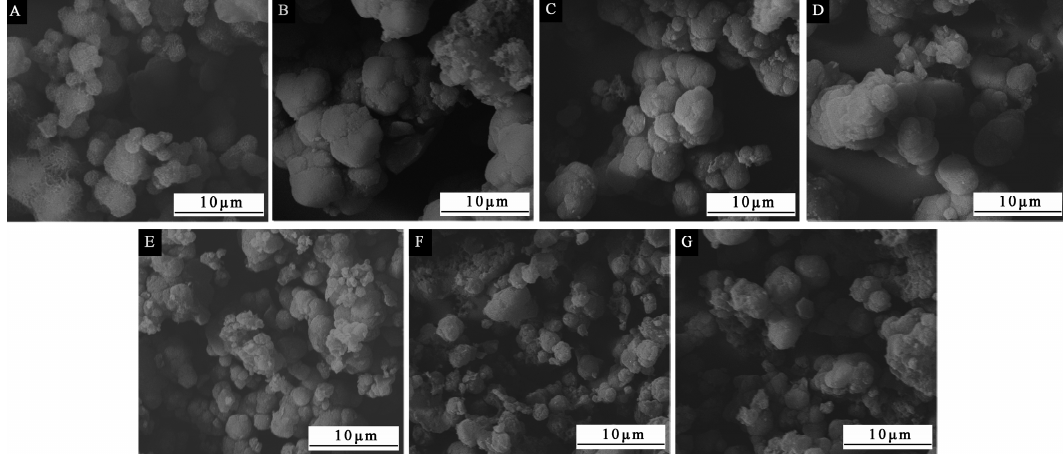
Figure 3. The SEM morphologies of microcapsules with different core–wall ratios: ( A ) 0.42:1, ( B ) 0.50:1, ( C ) 0.58:1, ( D ) 0.67:1, ( E ) 0.75:1, ( F ) 0.83:1, ( G ) 0.92:1.